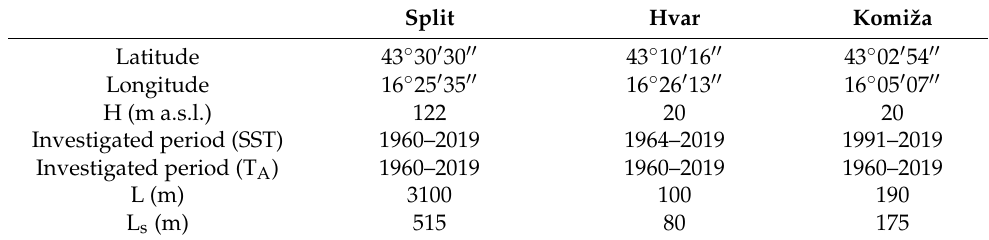
Table 1. Characteristics of the investigated meteorological stations.